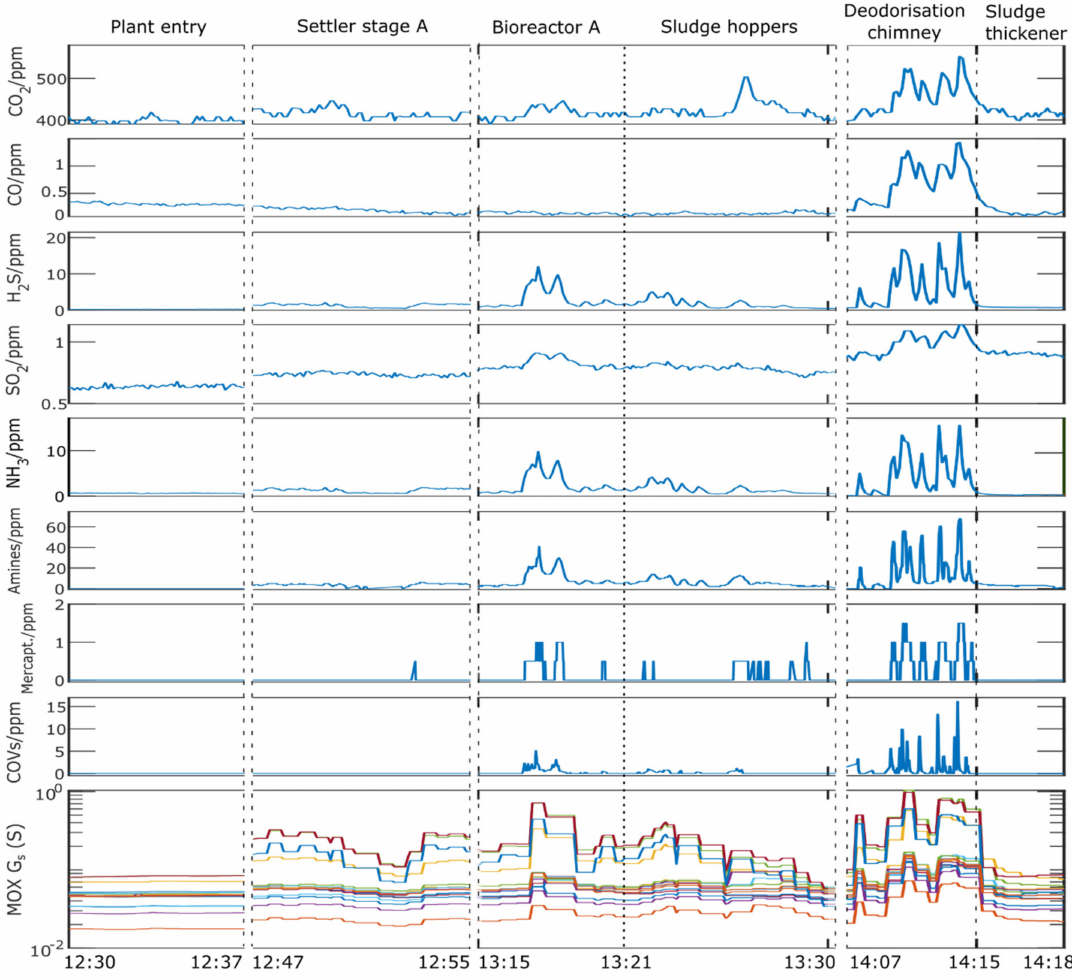
Figure 6. Raw sensor signals during the field